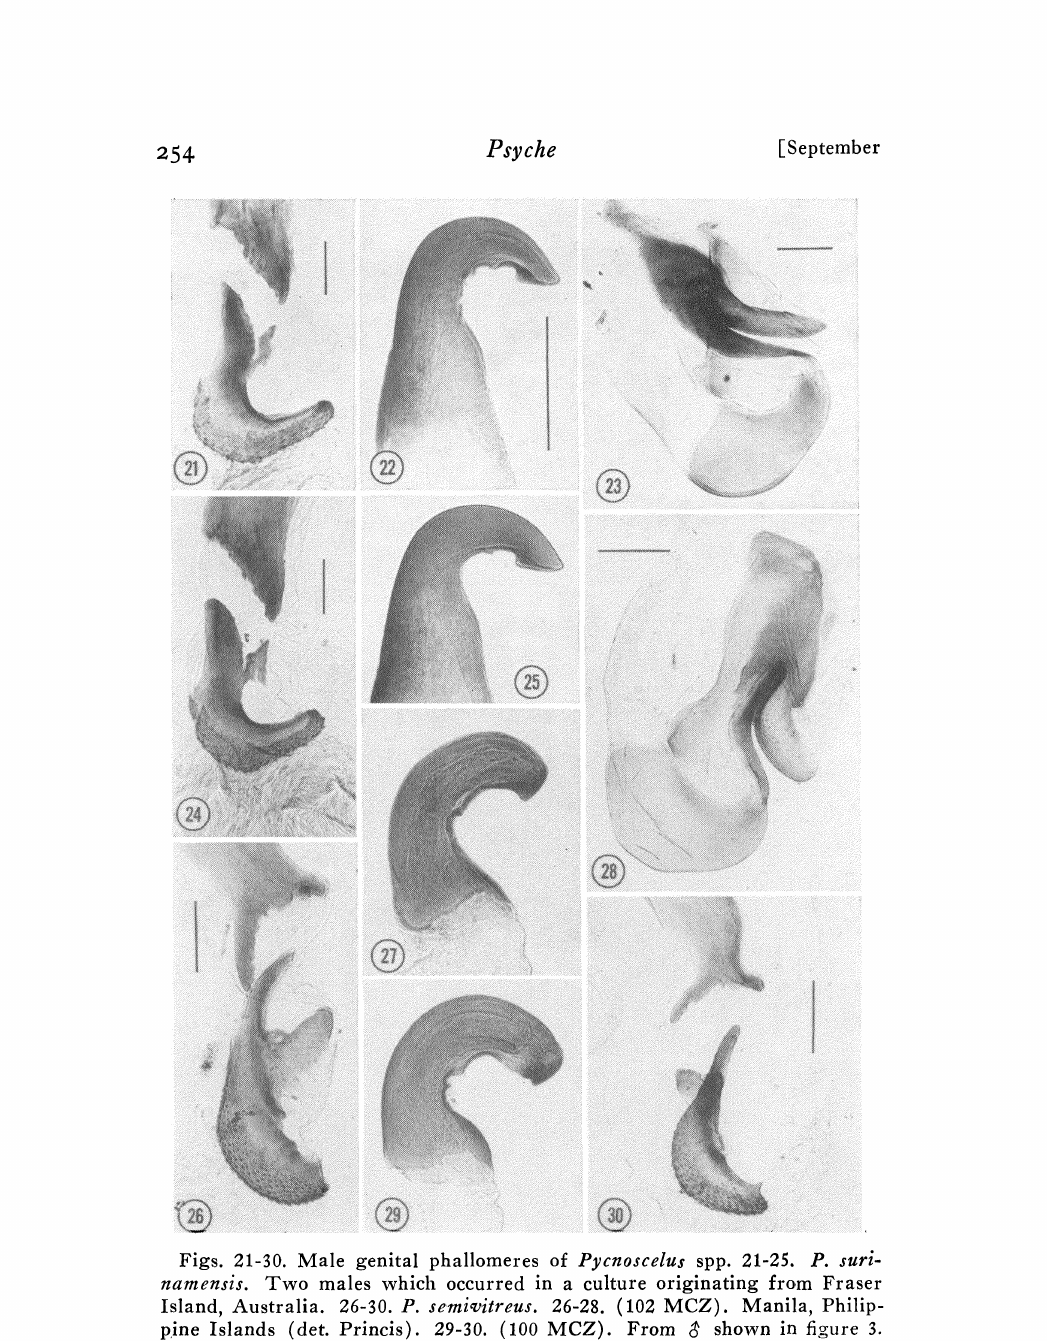
’ shown in figure 3.